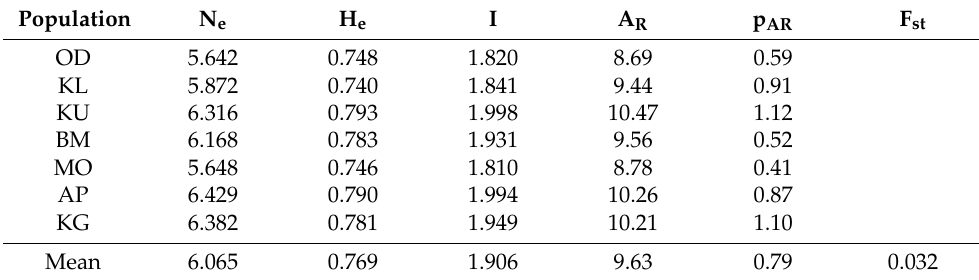
Table 4. Genetic diversity parameters at the population level based on twelve SSR loci: Ne (number of effective alleles), H e (expected heterozygosity), I (Shannon’s information index), A R (allelic richness), p AR (private allelic richness), F st (Wright’s fixation index).